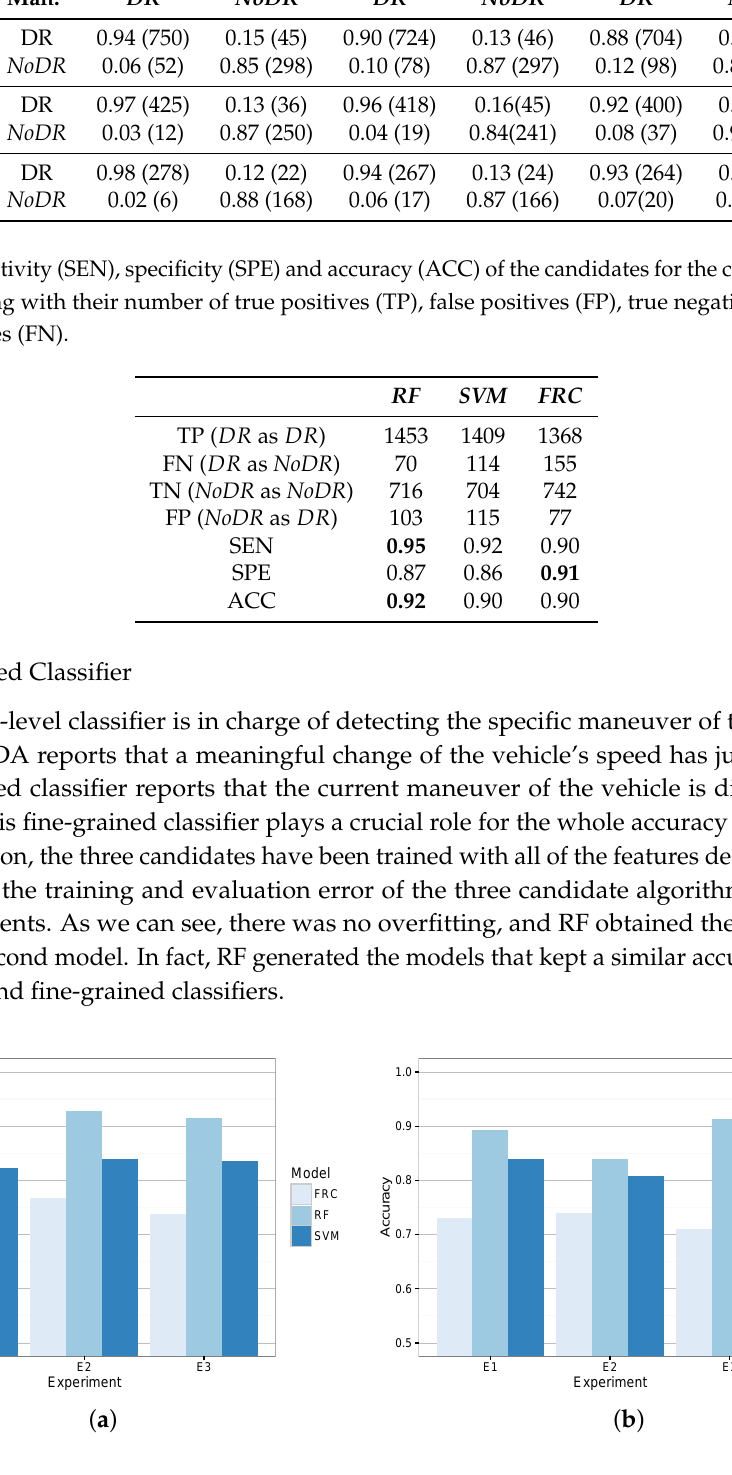
Figure 8. Fine-grained classifier candidates’ accuracy. ( a ) Training error; ( b ) evaluation